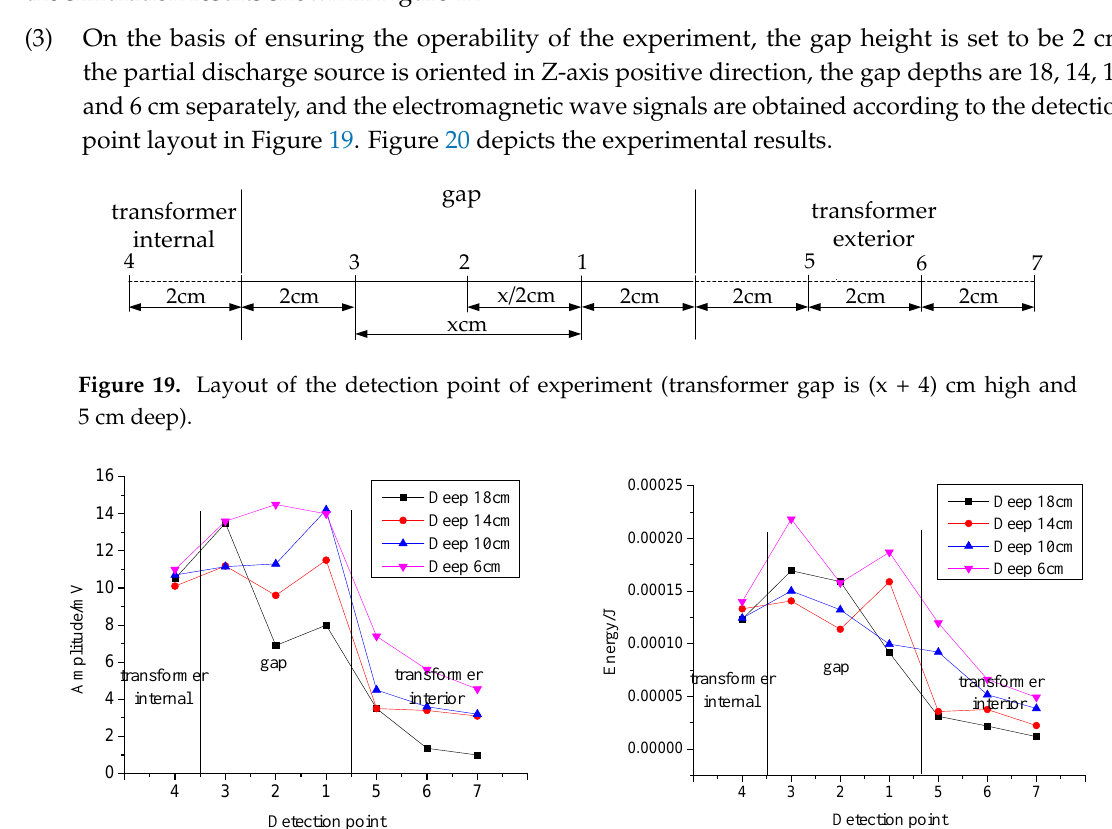
Figure 18. Distributions of PD electromagnetic signals in different height gaps in experiment: ( a ) Amplitude distribution; ( b ) Cumulative energy distribution.